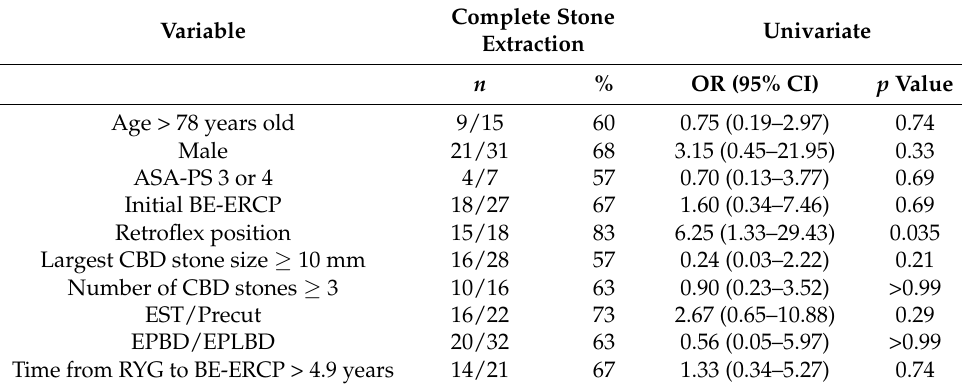
Table 5. Potential factors associated with complete stone extraction ( n = 36, Largest CBD diameter ≥ 14